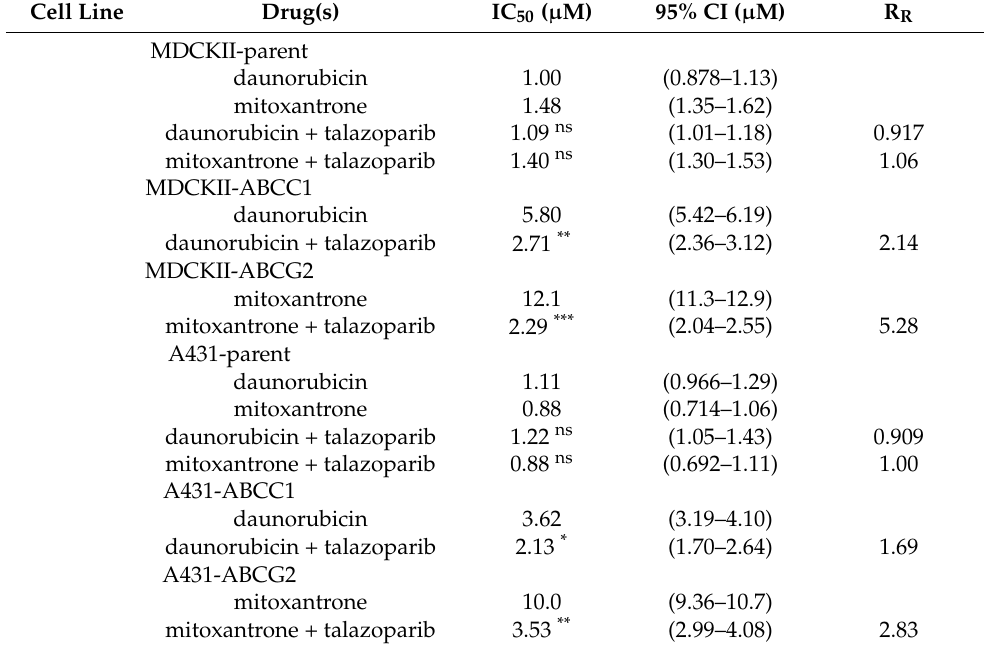
Table 1. IC 50 values and related IC 50 shift analysis of the combination of 5 µ M talazoparib with cytostatic substrates (daunorubicin and mitoxantrone) in MDCKII and A431 cell lines. IC 50 values were calculated using the data shown in Figure 6, and possible differences between IC 50 s were subsequently analyzed using the two-tailed unpaired t -test (* p < 0.05; ** p < 0.01; *** p < 0.001; comparing IC 50 s from single-drug treatments with IC 50 s of combinations in individual cellular subcultures). The reversal ratio (R R ) is the ratio of the IC 50 for single-drug treatment to that for the combined-drug treatment in the particular